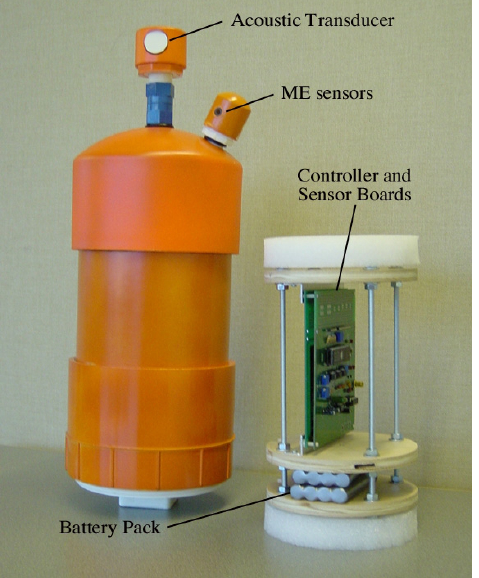
Figure 3a . Photograph of an aqueous sensor network node. The electronics are mounted on a frame (right), which is inserted into the PVC housing of diameter 16.5 cm and length 30.5 cm. The acoustic transducer is mounted at the center top.